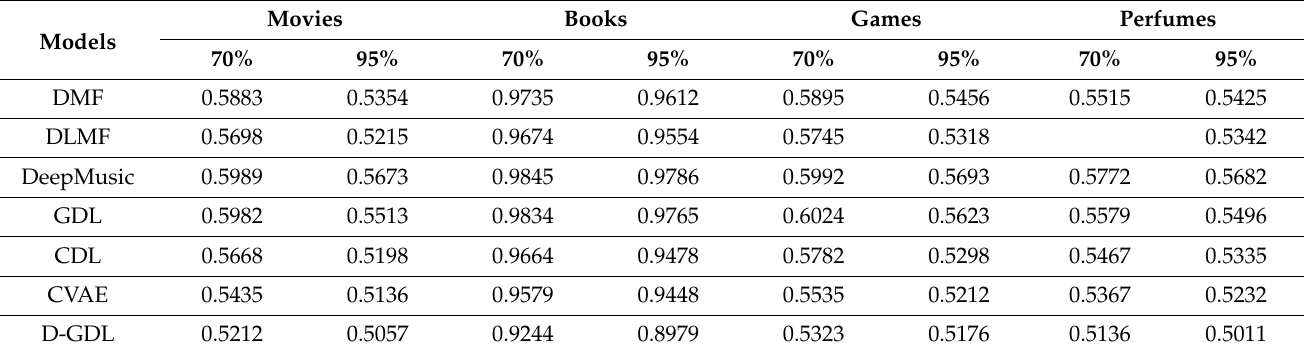
Table 5. Average RMSE of the comparative approaches using different percentages of training data on the four datasets of